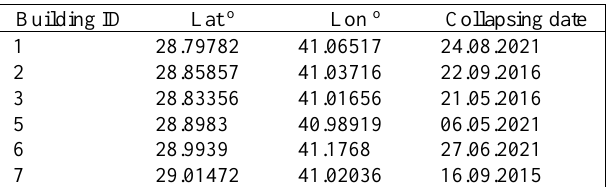
Table 1. The list of collapsed